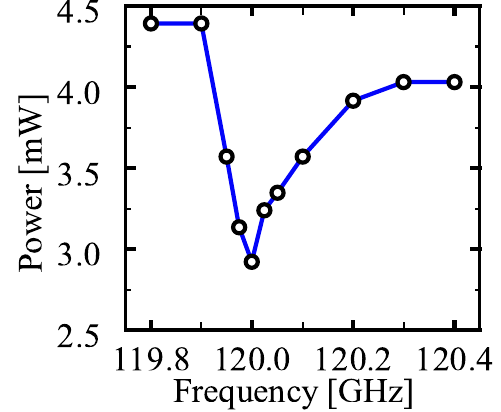
FIG. 7. (Color) FFT of the IF frequency from the double het- erodyne receiver operating near 240 GHz, the 14th harmonic of the accelerator frequency. A narrow bandwidth of 28 MHz FWHM is